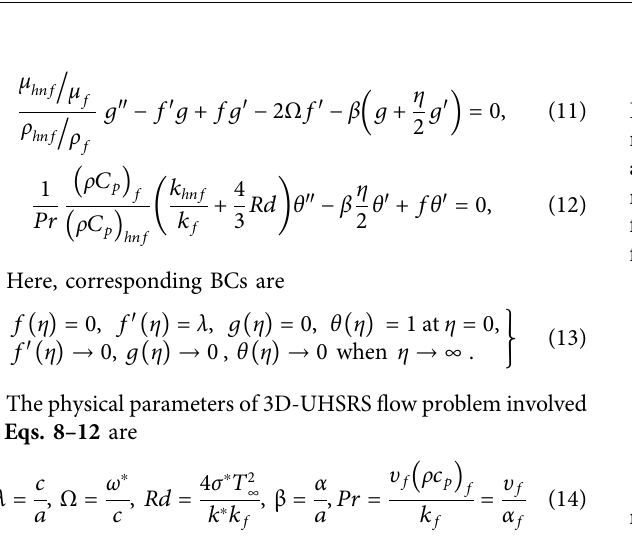
FIGURE 7 | Mean square error bases performance of second cases for all